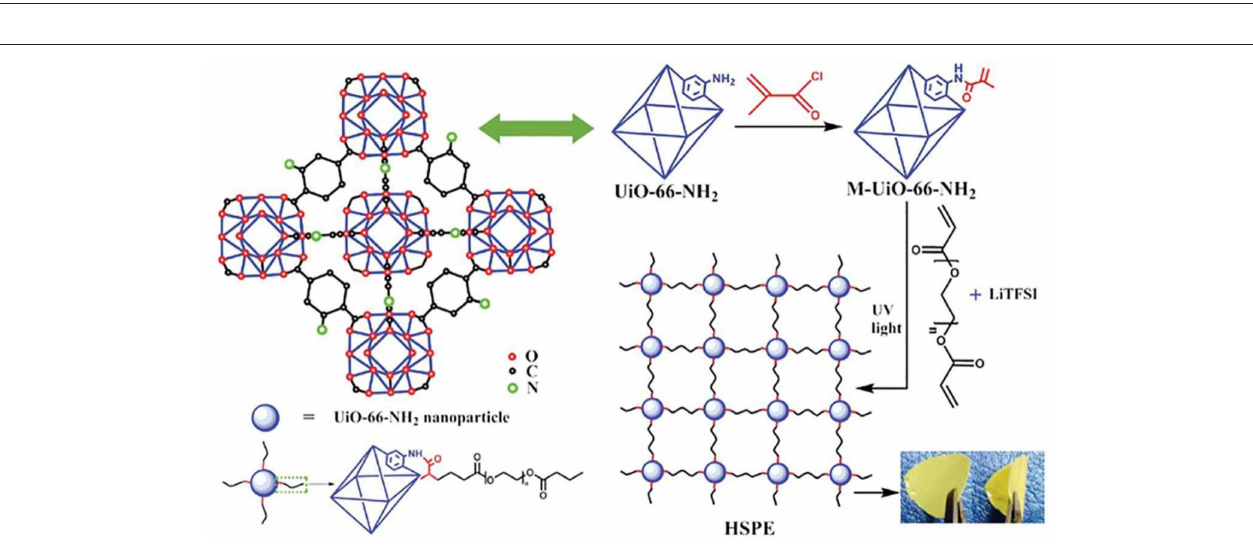
FIGURE 11 | Synthetic route of the hybrid covalently linked MOF-PEGDA-based all-solid-state electrolyte. [Reproduction with permission from Wang Z. et al. (2018). Copyright © 2018, The Royal Society of